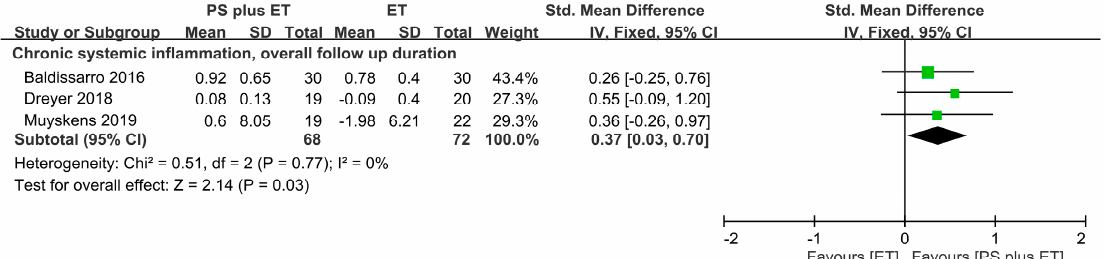
Figure 6. Forest plot summarizing the effects of postoperative protein supplementation (PS) plus exercise training (ET) on changes in systemic inflammation level during an overall follow-up duration. For each trial, the square represents the point estimate of the intervention effect. The horizontal line links the lower and upper limits of the 95% CI of this effect. The area of the squares reflects the relative weight of the trials in the meta-analysis. Trial results plotted on the right-hand side of the vertical axis indicate effects in favor of protein supplementation. The combined effects are plotted using black diamonds. 95% CI, 95% confidence interval; Std, standard; IV, inverse variance.